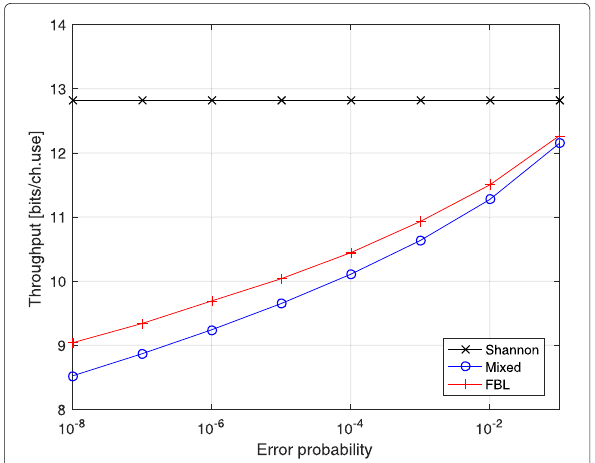
Fig. 3 Throughput vs. target error probability with blocklength v =